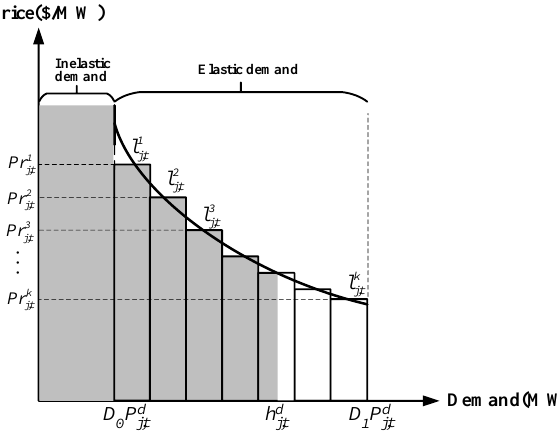
Figure 2. Step-wise function approximation of PEDR curve.